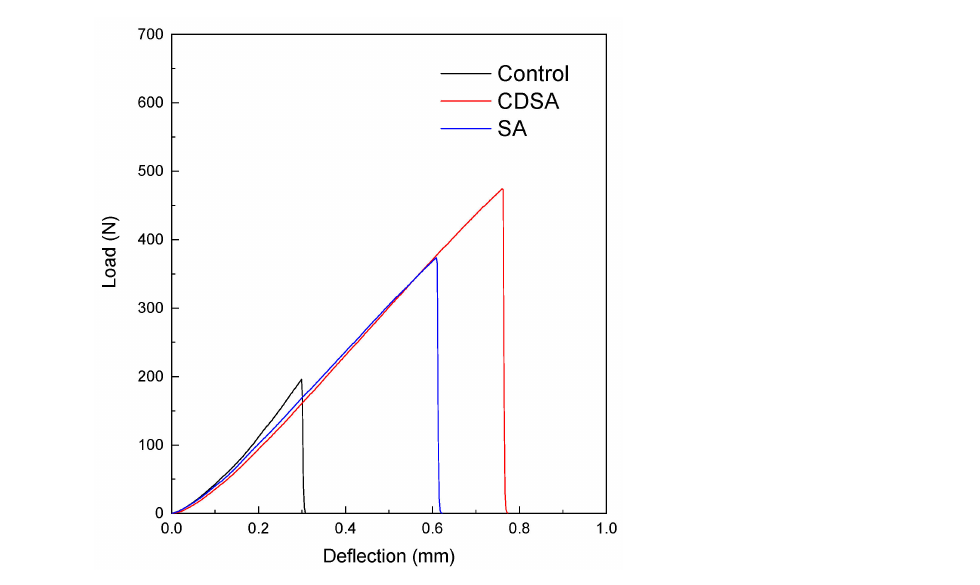
Figure 10. Load-deflection curves of control and the epoxy thermosets containing 10 wt% PCL -b- PE - b- PCL via CDSA or SA.